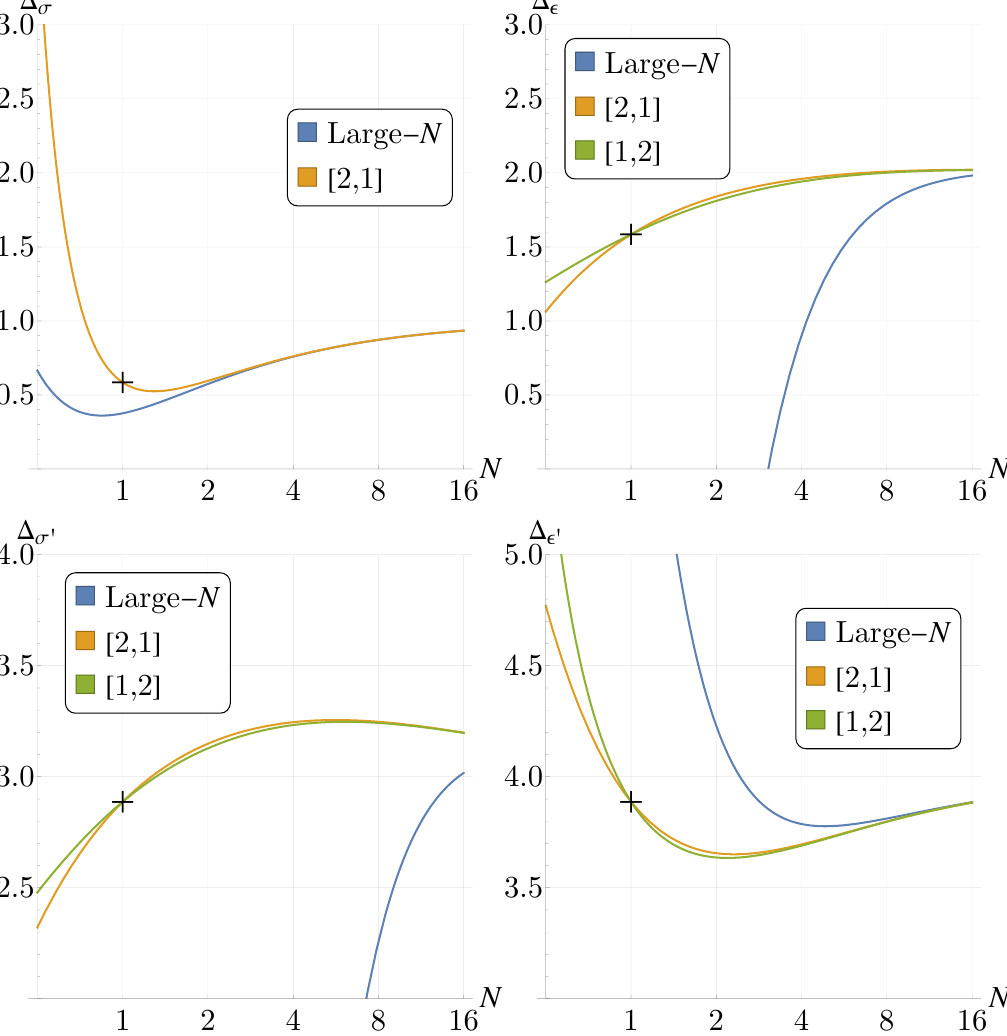
Figure 3 . Two sided-Padé approximation for the scaling dimensions of low-lying scalars, singlets under the O ( N ) global symmetry. The results are found using the results for the N = 1 super-Ising model and the large- N estimates for the GNY